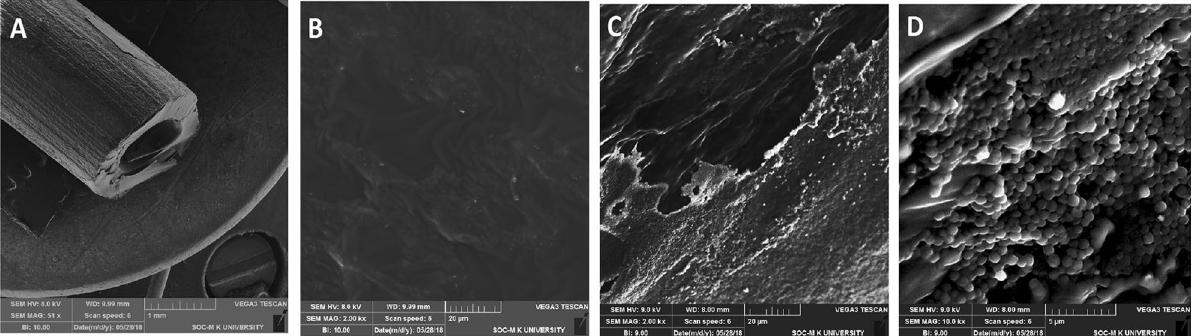
Figure 15. Representative SEM images of dense biofilm formation on the surfaces of uncoated ( A , C , D ), EL-LP- CuNPs coated catheters ( B